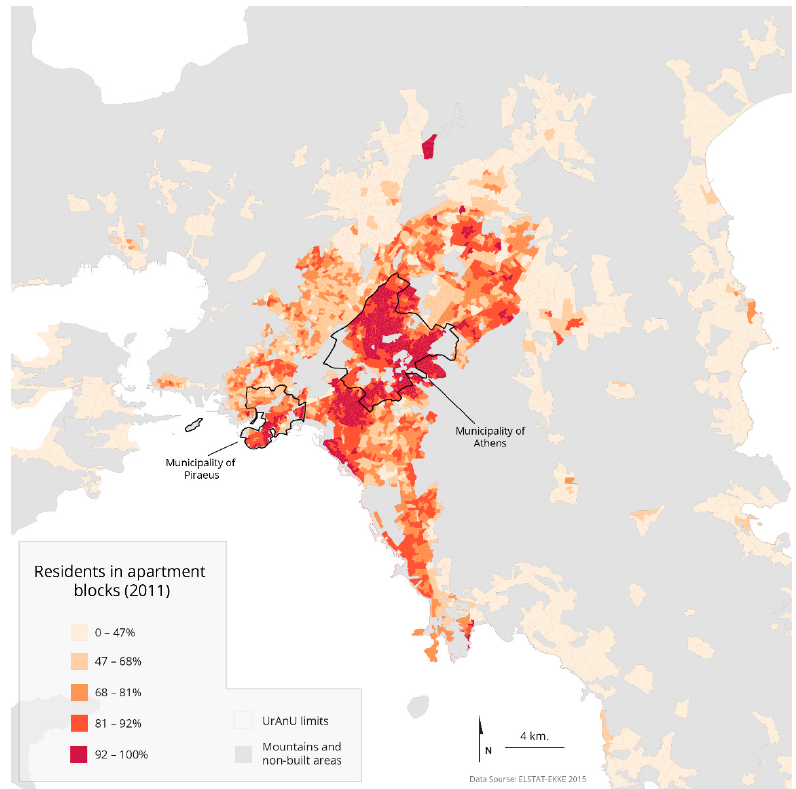
Figure 2. Percentage of residents living in apartment blocks, in the Athens metropolitan area, by URANU (2011).